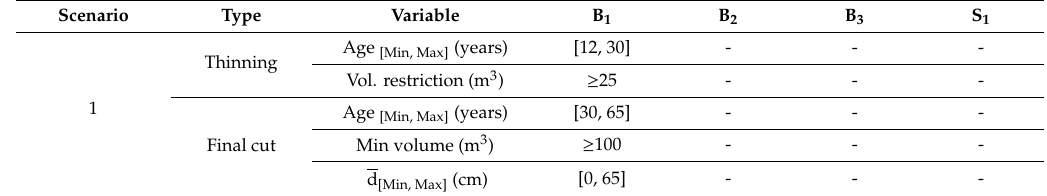
Table A2. Definition of thinning and harvesting parameters per scenario and